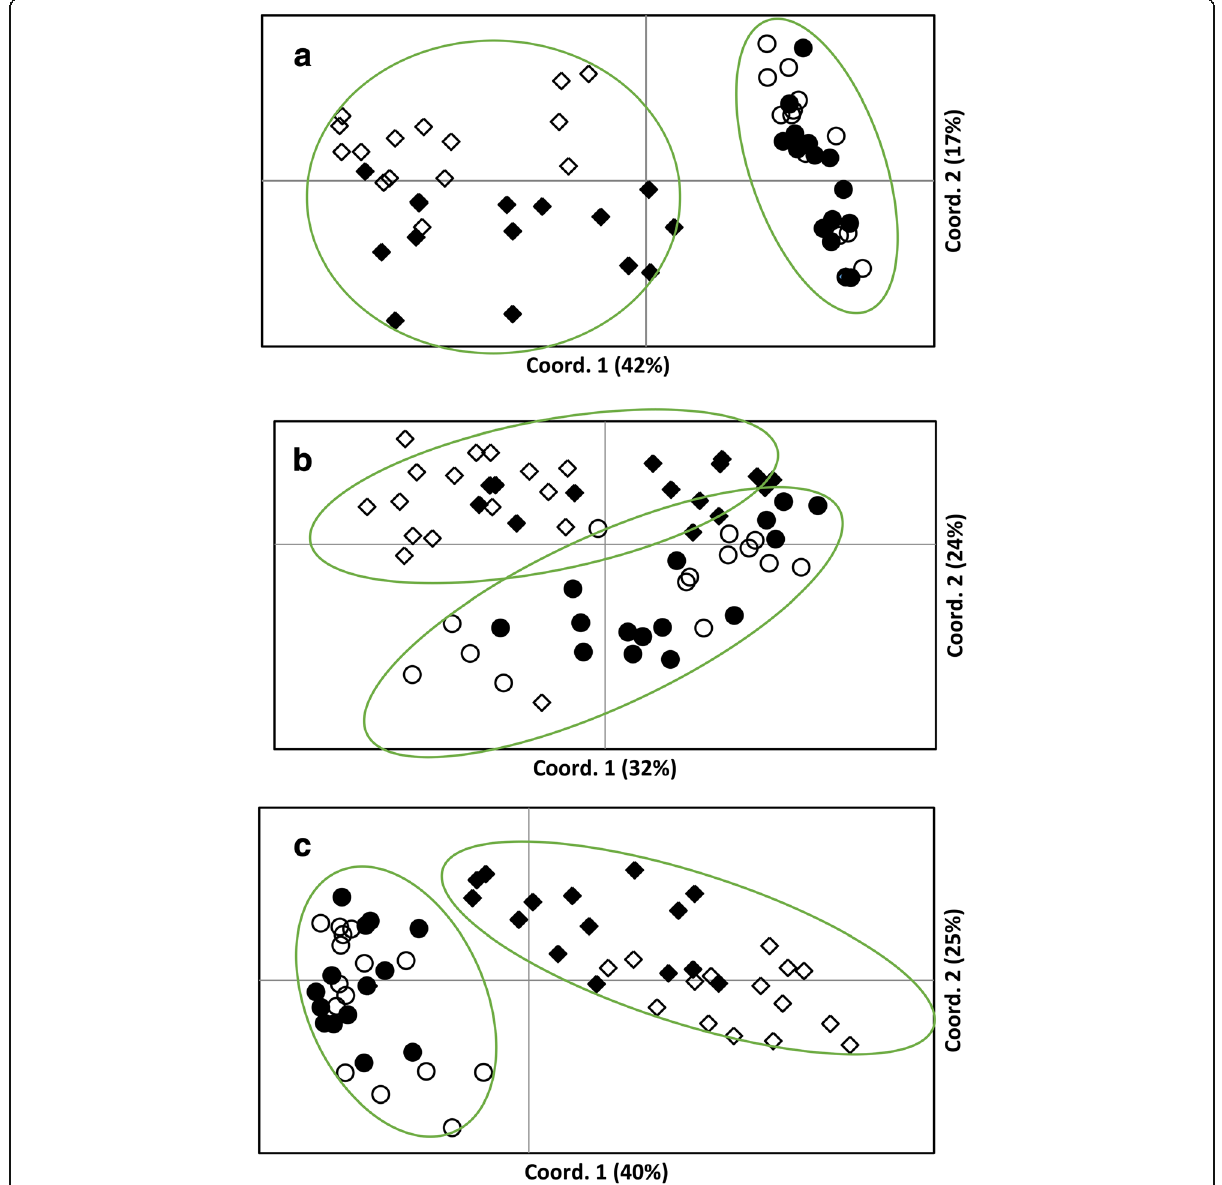
Fig. 3 Scatter diagram of the 60 healthy and infected B. hyrcana genotypes originating from two populations Tuscatoc and Escolac in Hyrcanian forests on the basis of data from ISSR ( a ), RAPD ( b ) and combined ISSR and RAPD ( c ). Healthy trees from Tuscatoc, black diamond; infected trees from Tuscatoc, white diamond; healthy trees from Escolac, black circle; infected trees from Escolac, white